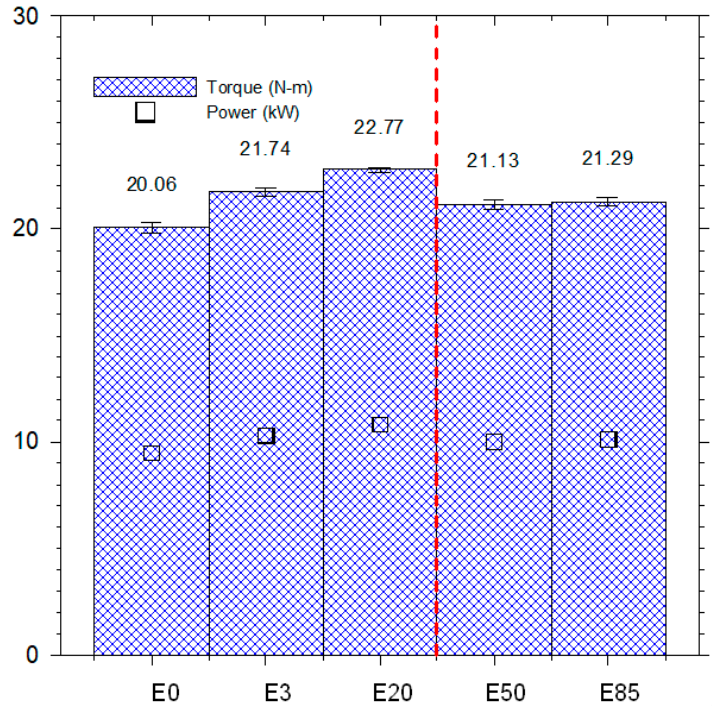
Figure 9. Power (KW) / torque(N-m) t for ethanol/gasoline blended fuel.